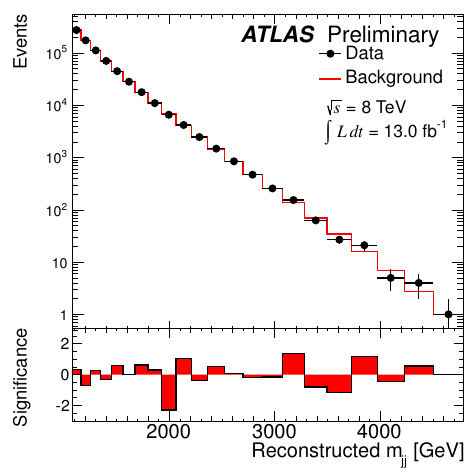
Figure 1. The dijet invariant mass distribution fitted with a smooth function. The significance of the data-to-fit di ff erence is reported for each bin [4].